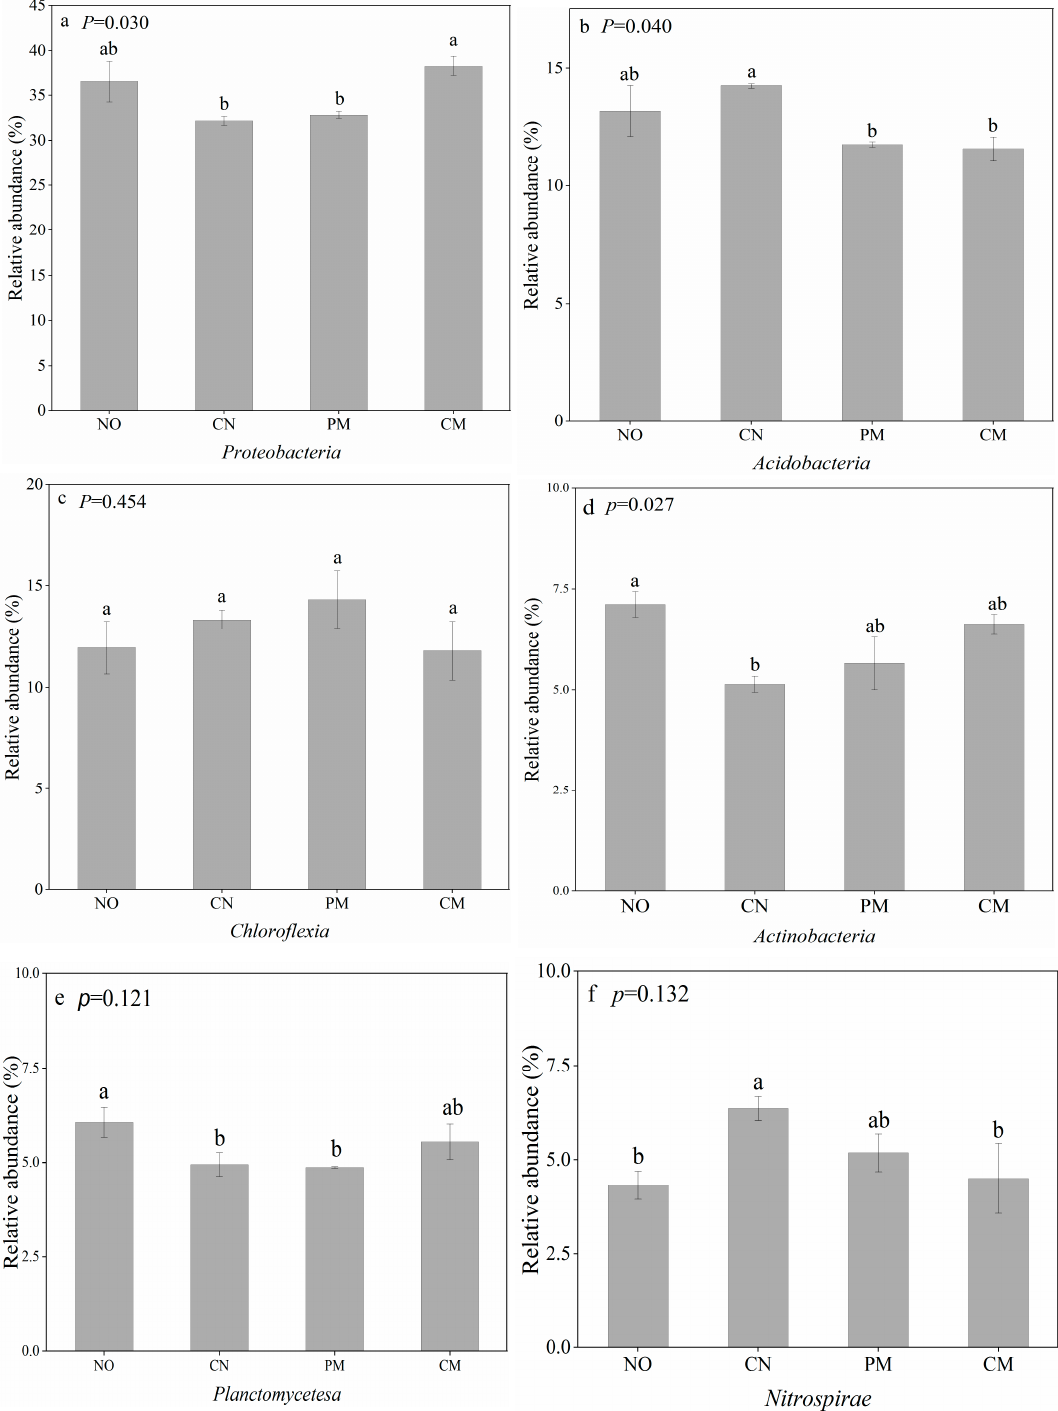
Figure 3. Comparison of the relative abundances of six bacteria phyla of the top 10 dominant bacteria phyla across treatments ( Proteobacteria , Acidobacteria , Chlorofexi , Actinobacteria , Planctomycetes and Nitrospirae for ( a – f ) respectively). Bars indicate the standard error ( n = 3). Different letters above columns within the same species indicate significance at p < 0.05, according to Duncan’s test. NO: no N fertilizer. CN: 100% urea N with no organic fertilizer. PM: 80% urea N plus 20% N with pig manure. CM: 80% urea N plus 20% N with